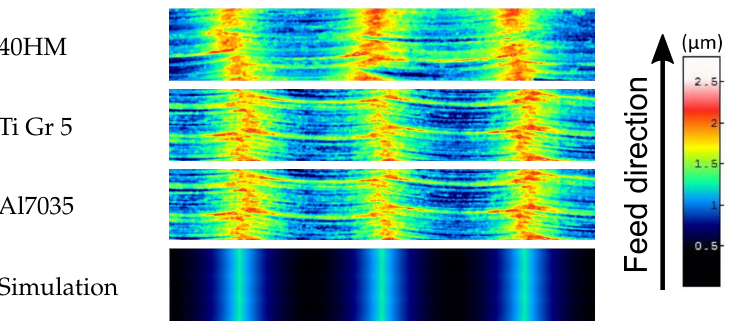
Figure 8. Surface parts with dimensions of 0.2 mm × 1.2 mm from the measured surface topogra- phies of samples made of various materials and the surface obtained from simulation with milling parameters b r = 0.4 mm , f t = 0.06